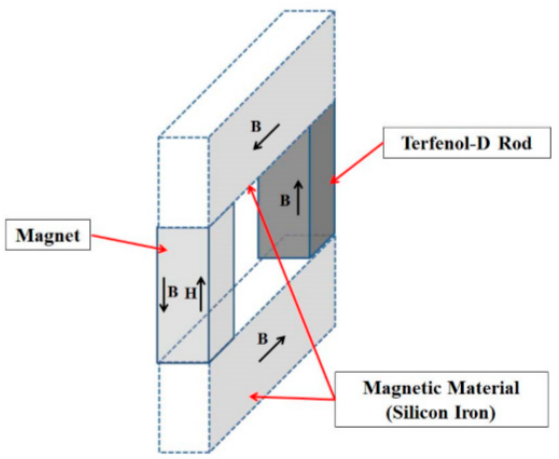
Figure 9. Optical fiber current sensor based on 70 g rectangular magnetostrictive material.